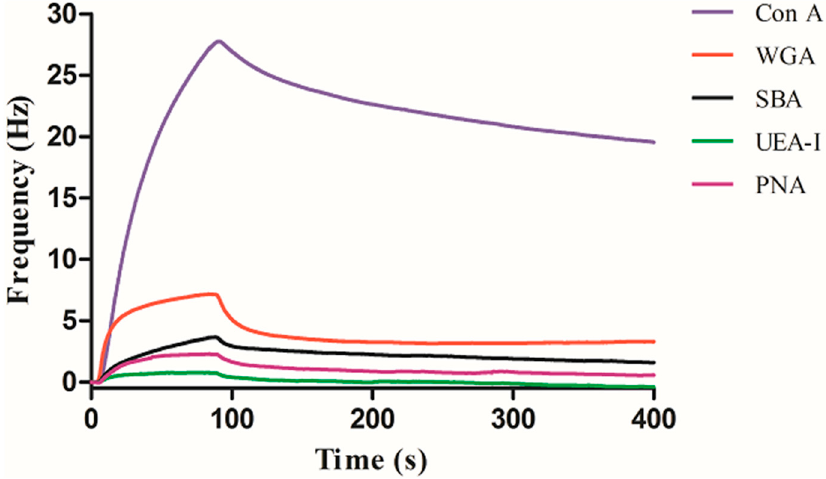
Figure 6. Interaction of mannose with a series of lectins.